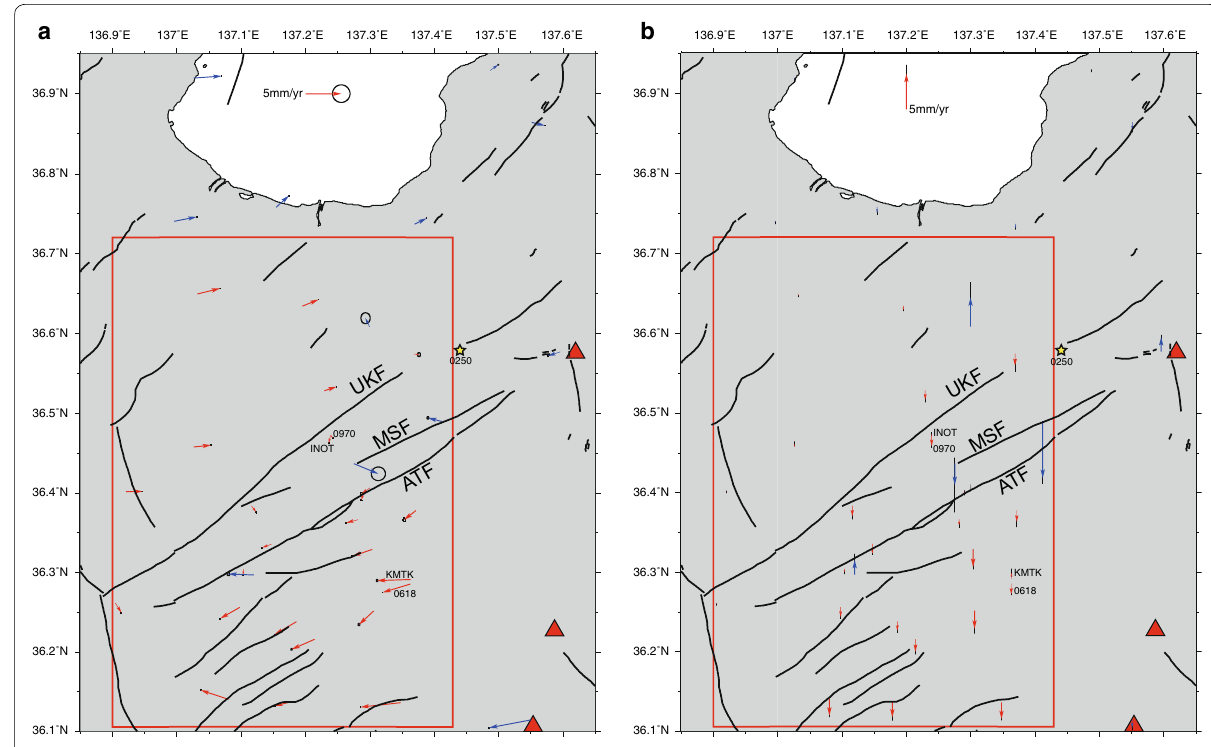
Fig. 6 GNSS velocity field. a Horizontal components and b vertical component with respect to 0250 (star). Red arrows indicate the velocity vectors used for the correction of the interferograms. Blue arrows are those not used for the correction. For horizontal components, the ellipse at the tip of each vector represents the 95% confidence interval. For vertical components, the error bar at the tip of each vector represents the 95% confidence interval. The red frame indicates the area shown in Figs. 5 and 7. Triangles indicate active volcanoes. Black lines represent active